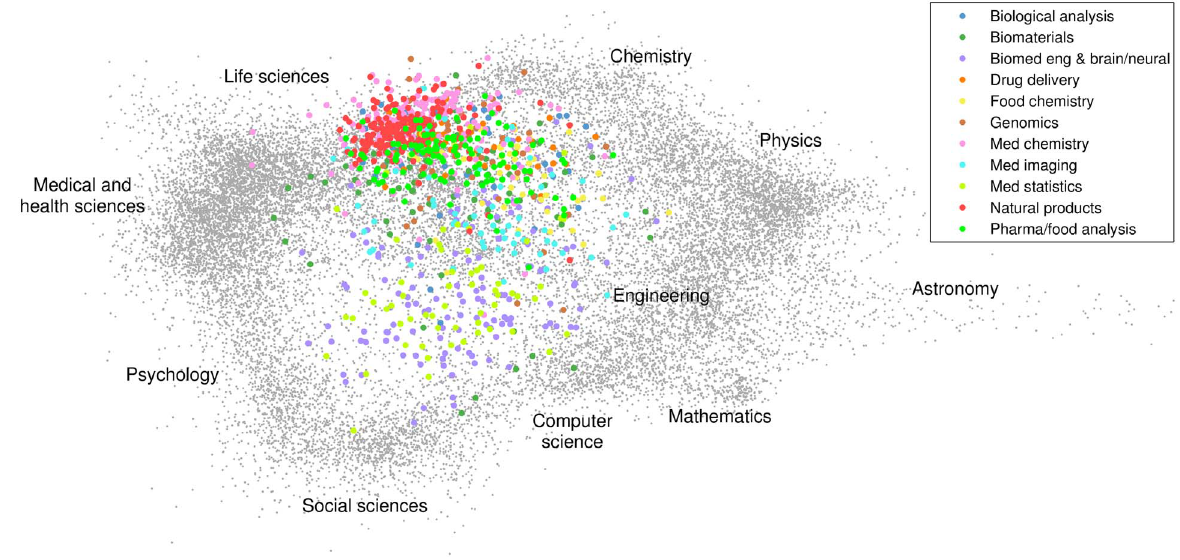
Figure 11. The 11 broad research themes at the EPS-HLS interface and their location within the general structure of science. doi:10.1371/journal.pone.0111530.g011 PLOS ONE |